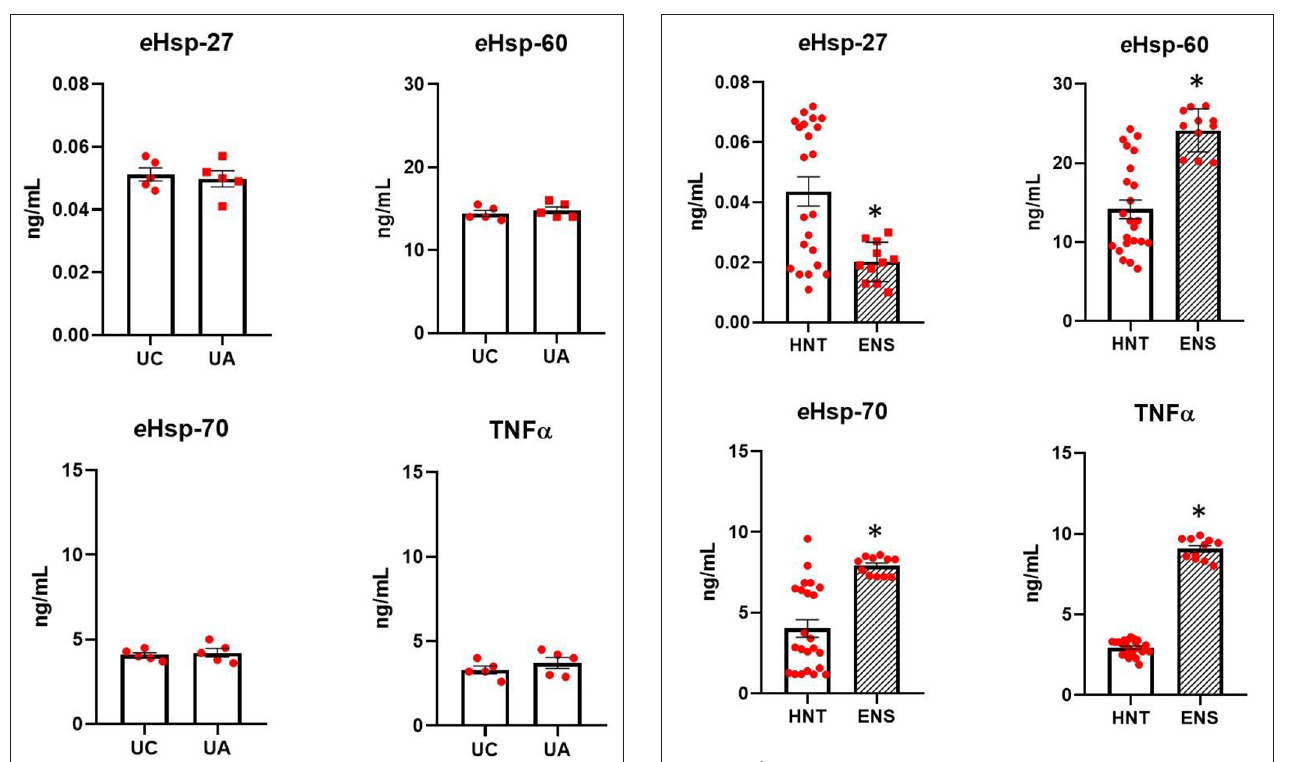
neonatal sepsis compared with healthy neonates at term 1.6-fold (14.15 ± 5.7 vs. 24.7 ± 3.0 pg/ml, p ≤ 0.001), 2.0-fold (4.03 ± 2.6